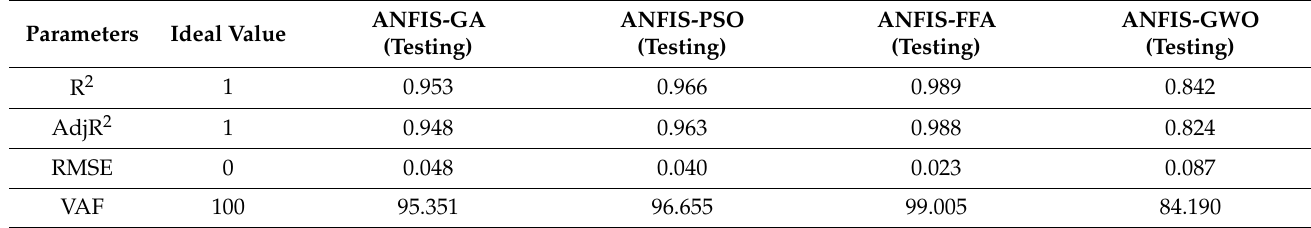
Table 3. Comparison of model prediction power (testing